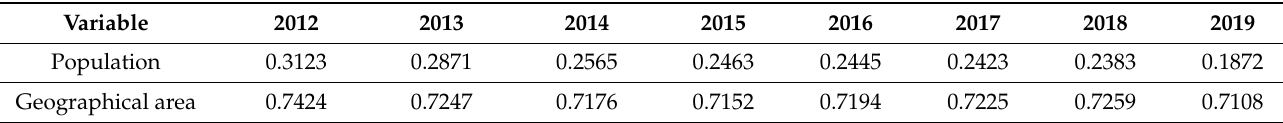
Table 6. The Gini coefficients of GP allocation in 2012–2019.